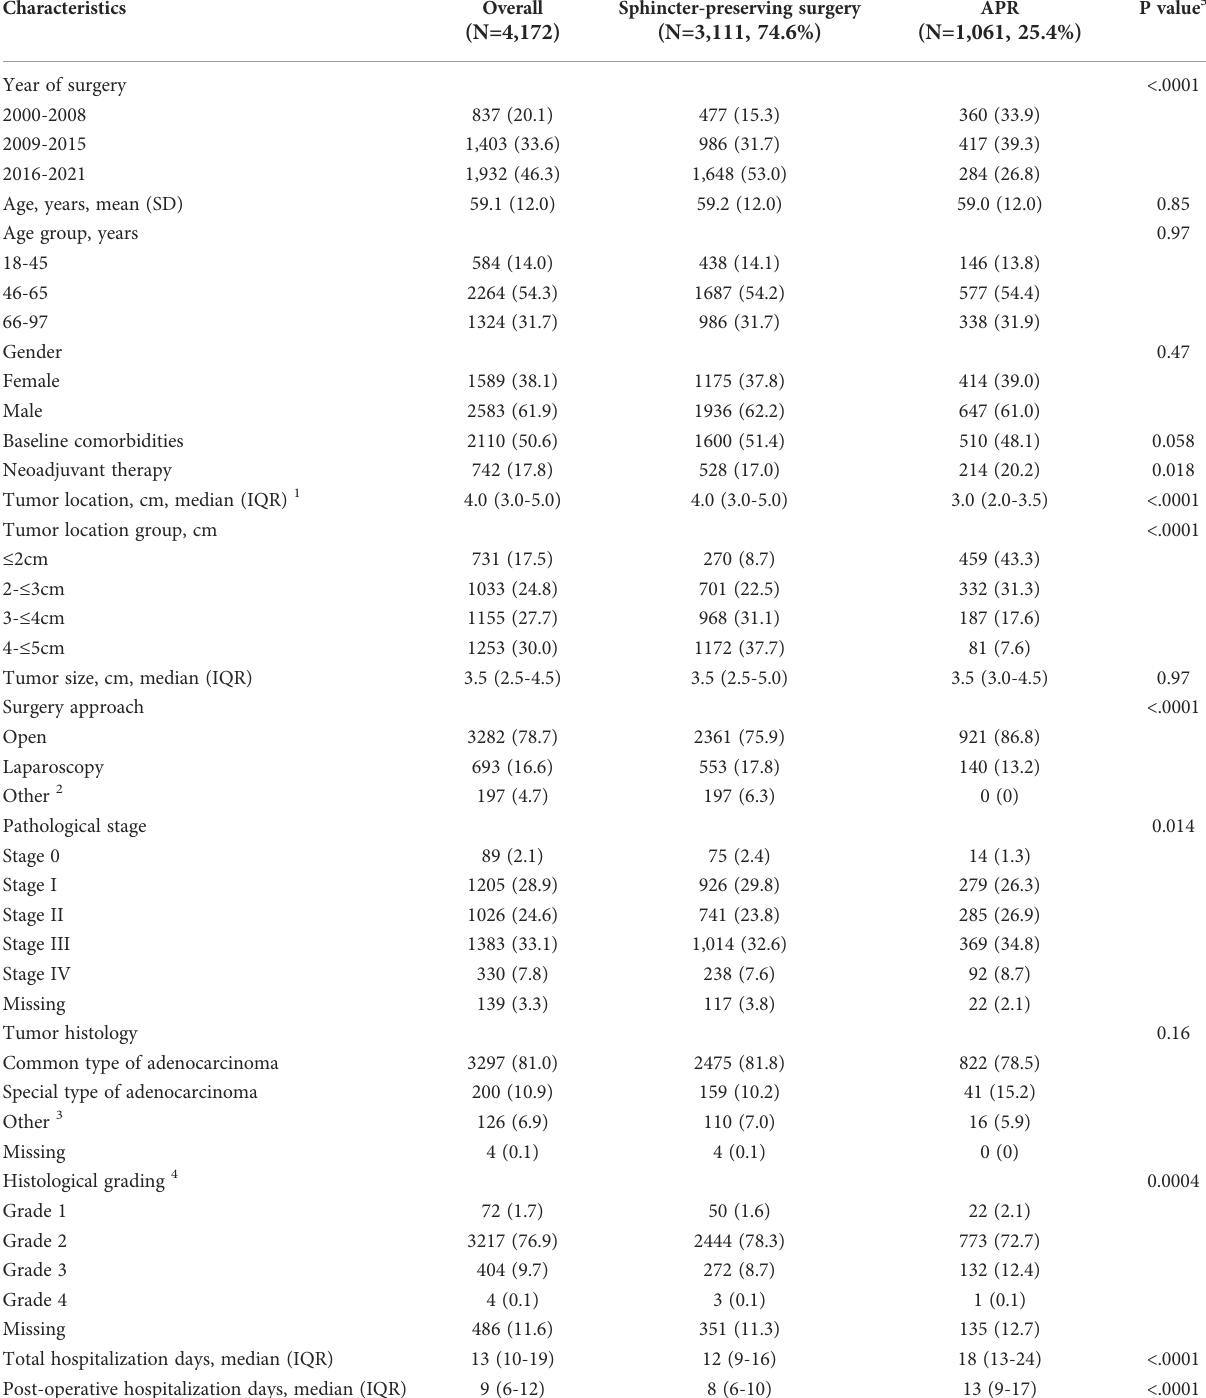
TABLE 1 Characteristics of patients with low rectal cancer, stratifying by sphincter-preserving surgery and APR.